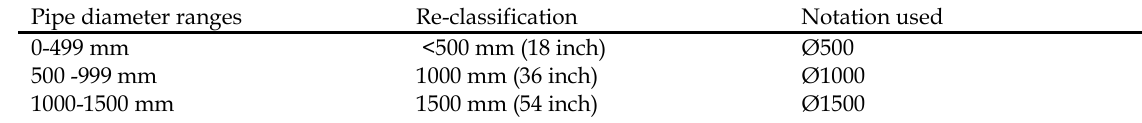
Table 2. Re-classification of pipes into three broad categories. Pipe diameter